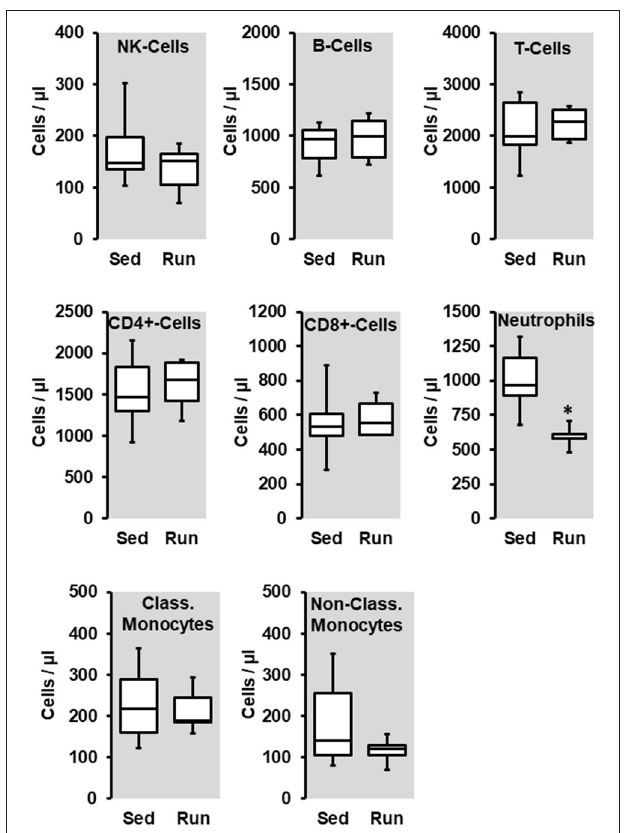
FIGURE 1 | Effect of 10 months voluntary running wheel activity (Run) on blood cell concentration in normotensive rats compared to sedentary controls (Sed). Box plots represent 25, 50, and 75 percentiles with 5 and 95 percentiles given as whiskers. * p < 0.05; unpaired T -Test.